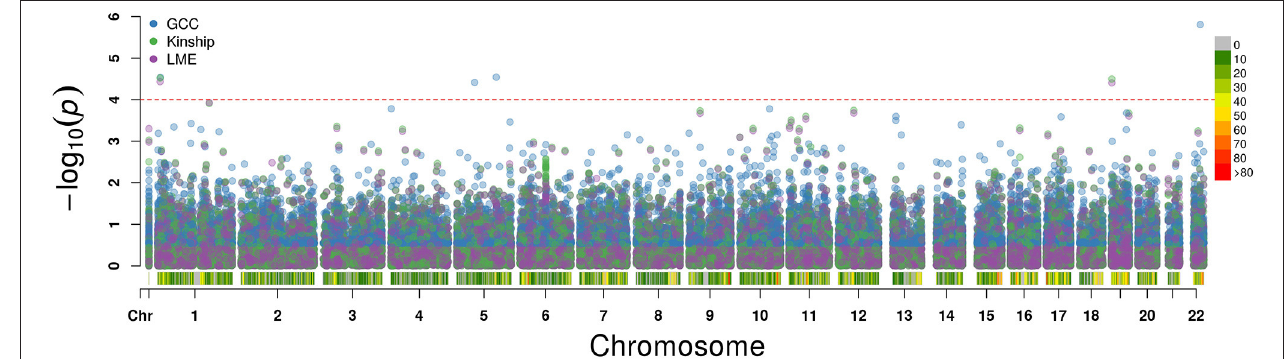
FIGURE 2 | Manhattan plot for single mRNA probe analysis from GCC, kinship, and LME models along each chromosome.